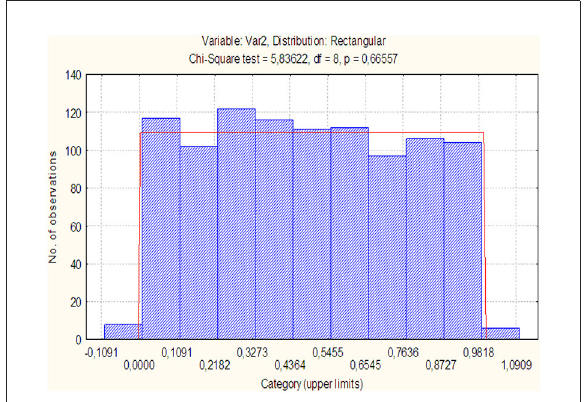
FIGURE1 Checking for the uniformity of the metric distribution δ 1 .